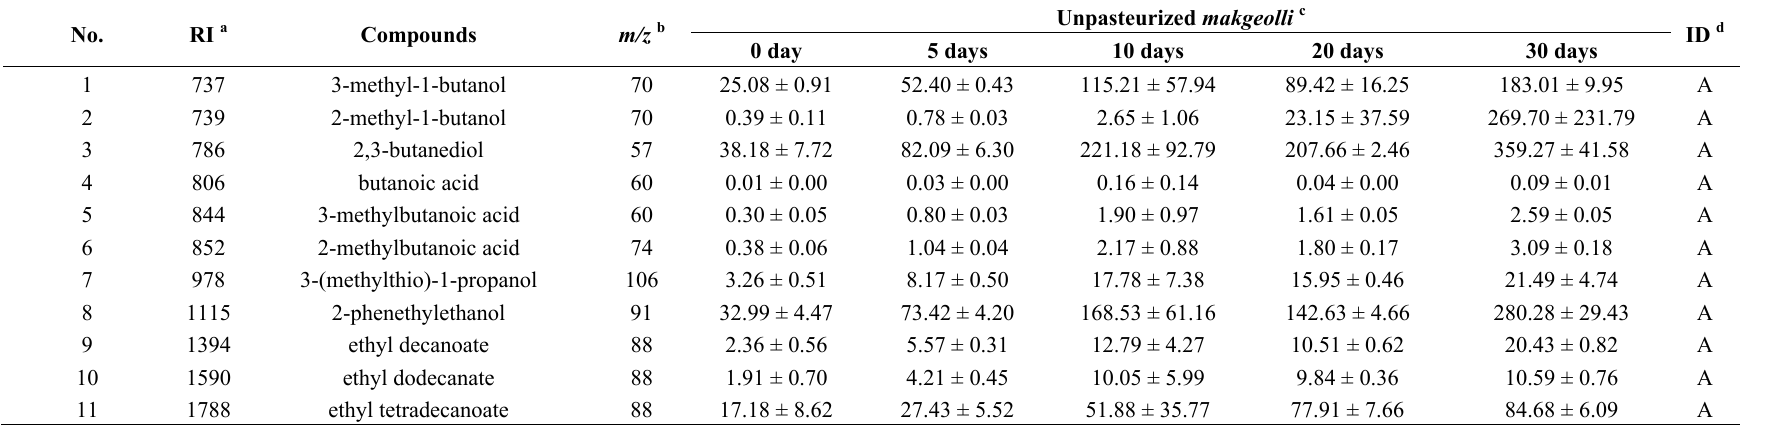
Table 2. The concentrations of odor-active compounds in unpasteurized makgeolli during storage.